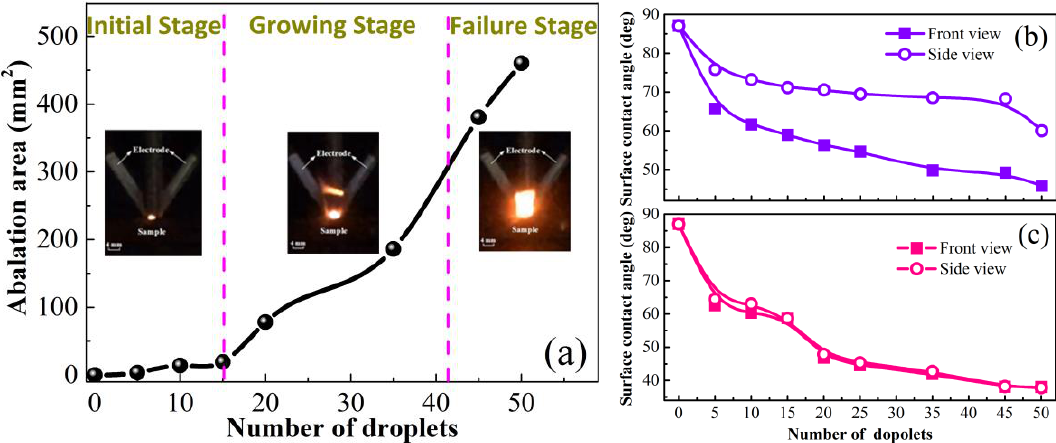
Figure 6. Evolution of the ablation area of 1 wt% nano-MgO-doped samples, at 500 V during the surface tracking measurement ( a ) and the corresponding contact angles in Region B ( b ) and Region C ( c ).